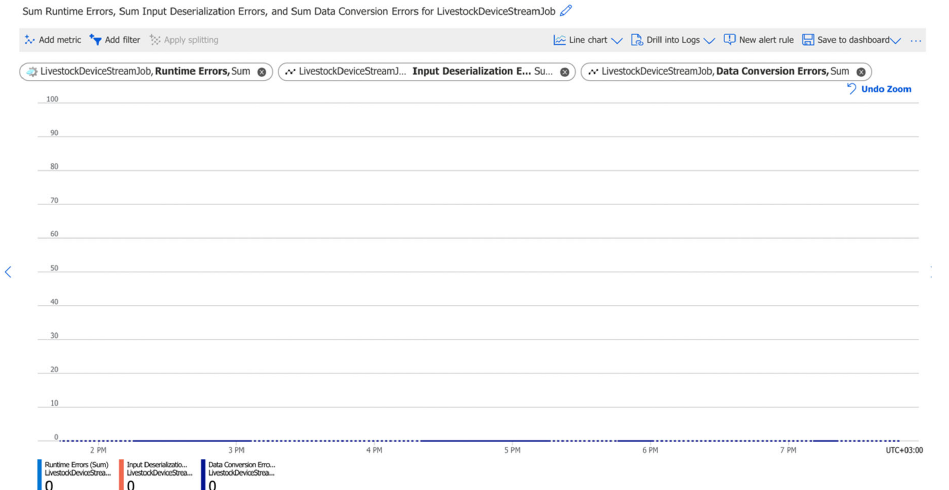
Figure 12. Stream Job Utilization Percentage. The blue line shows the percentage of CPU Utilization. The Red line shows the percentage of SU Utilization. The dotted line shows that no data is ingested for that period (when IoT devices are in sleep mode). 3.2. Azure Machine Learning Following the system architecture presented in Figure 6 in Section 2, the stored se ‐ lected data in blob storage are imported into the Azure Machine learning service. Before